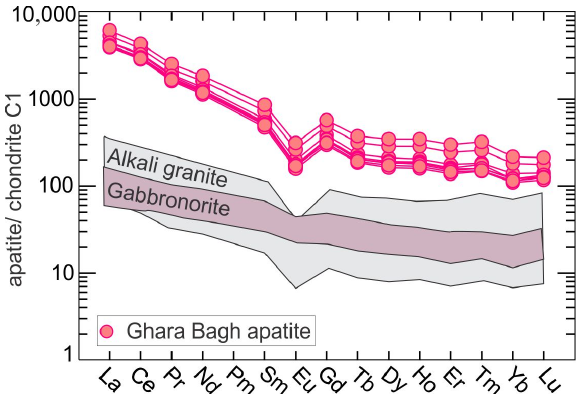
Figure 6. Chondrite C1-normalized rare earth element (REE) pattern of Ghareh Bagh mica mine. C1-normalizing values are from McDonough and Sun [43]. Data of the Ghushchi complex including alkali granite (grey field) and gabbronorite (purple field) from Moghadam et al. [27]. The REE normalized pattern indicates enrichment in LREE and negative Eu anomaly and shows a similar pattern to the Ghushchi Alkali granite.